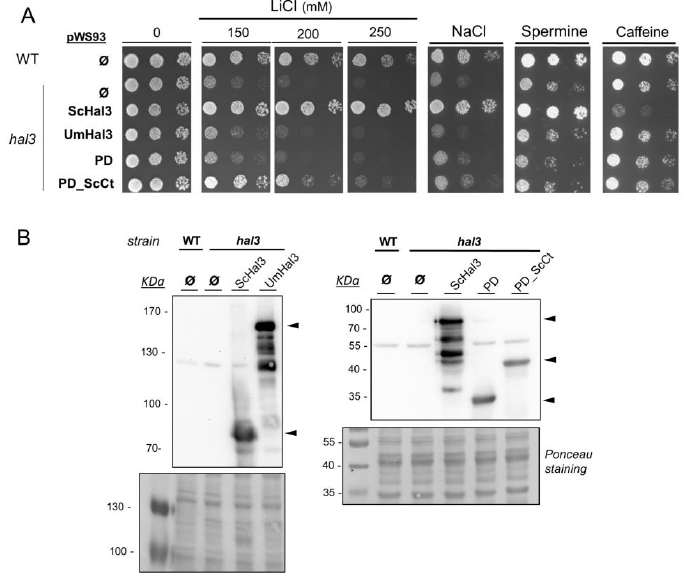
Figure 3. E ff ects of the expression of UmHal3 in S. cerevisiae on the tolerance to diverse stress conditions. ( A ) Wild type BY4741 (WT) and its hal3 derivative were transformed with plasmid pWS93 (episomal, URA3 marker) and the same plasmid expressing ScHal3, full-length UmHal3, its PPCDC domain (PD) and this domain followed by the acidic C-terminal tail form ScHal3 (PD_ScCt). Cells were spotted on